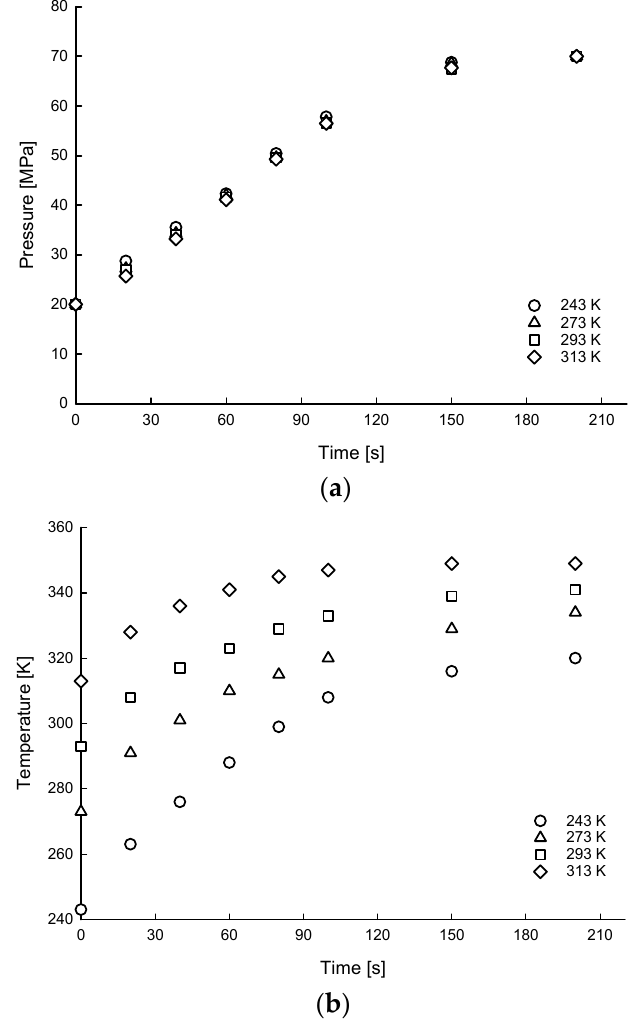
Figure 7. Time histories of hydrogen of average gas pressure ( a ) and temperature ( b ) distributions of filling process for 20 MPa SOC pressure condition under different ambient temperature condi- tions.